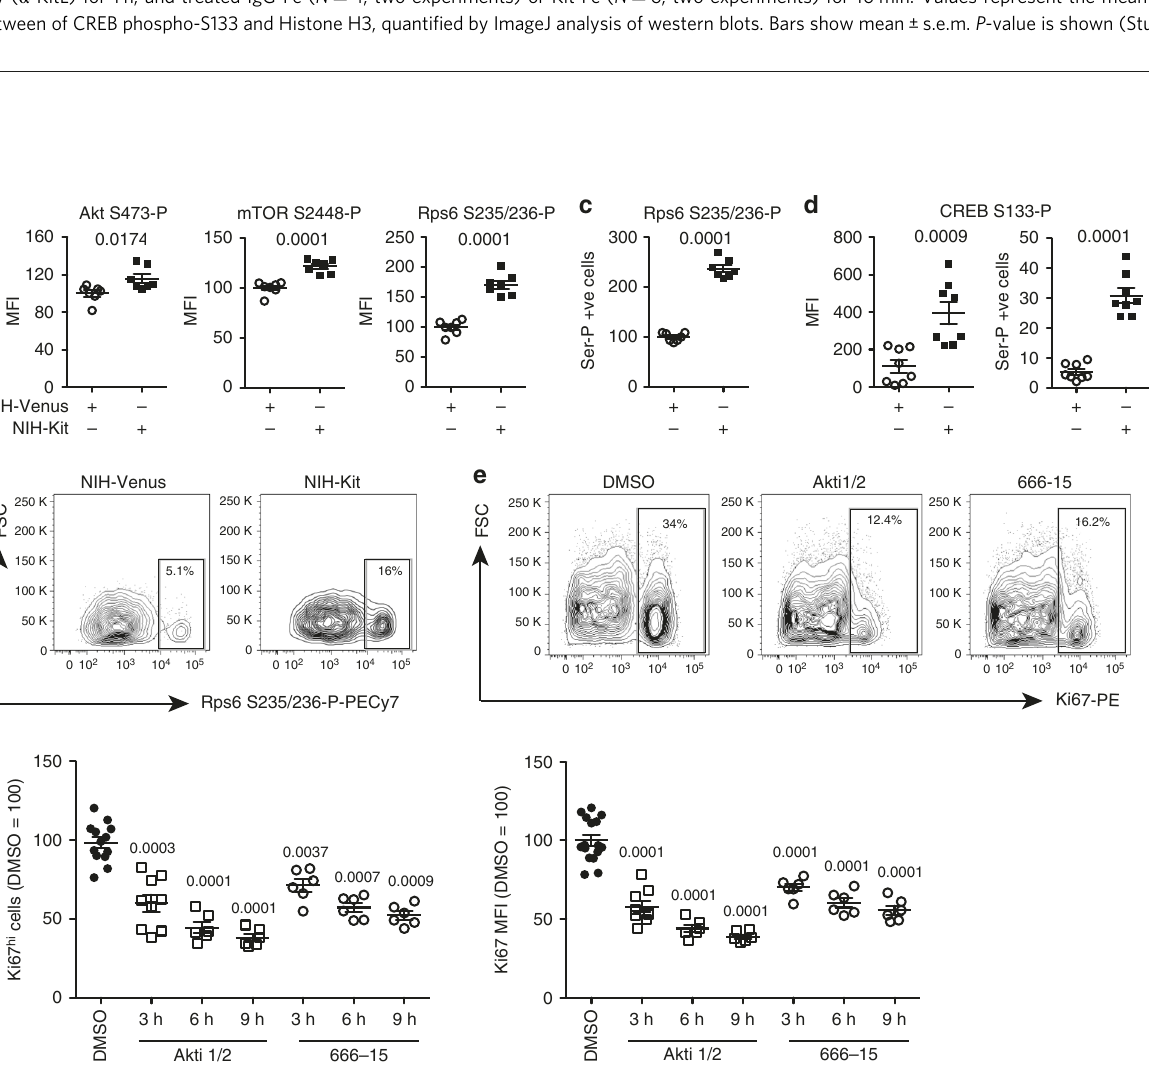
Fig. 2 mKitL signaling induces CREB and Rps6 phosphorylation. a ELISA quanti fi cation of CREB S133 phosphorylation in NIH3T3 treated with 200 ng/ml IgG-Fc ( N = 3, two experiments) or Kit-Fc ( N = 3, two experiments) at the indicated time points. Bars show mean ± s.e.m. P- value is shown (Student ’ s t - test). b ELISA quanti fi cation of Rps6 S235/S236 phosphorylation in NIH3T3 treated with IgG-Fc ( N = 3, two experiments) or Kit-Fc ( N = 3, two experiments) at the indicated time points. Values represent the mean of the ratio between Rps6 S235/S236 and Histone H3 at the indicated time points, quanti fi ed by ImageJ analysis of Western blots. Bars show mean ± s.e.m. P -value is shown (Student ’ s t -test). c ELISA quanti fi cation of Erk1 T202/Y204 + Erk2 T185/Y187 phosphorylation in NIH3T3 treated with IgG-Fc ( N = 3, two experiments) or Kit-Fc ( N = 3, two experiments) at the indicated time points, quanti fi ed by ImageJ analysis of western blots. Bars show mean ± s.e.m. No statistically signi fi cant differences were observed. d ELISA quanti fi cation of p38 α T180/Y182 phosphorylation in NIH3T3 treated with IgG-Fc ( N = 3, two experiments) or Kit-Fc ( N = 3, two experiments) at the indicated time points, quanti fi ed by ImageJ analysis of western blots. Bars show mean ± s.e.m. No statistically signi fi cant differences were observed. e Immuno fl uorescence analysis of NIH3T3 cells treated as in i showing CREB phospho-S133 (green) and DNA (blue, visualized with DAPI). Scale bars: 75 μ m. Data are representative of three experiments. f Quanti fi cation of CREB S133 phosphorylation in NIH3T3 cells pre-treated with goat-IgG (g-IgG) or goat anti-KitL antibody ( α -KitL) for 1 h, and treated IgG-Fc ( N = 4, two experiments) or Kit-Fc ( N = 6, two experiments) for 10 min. Values represent the mean of the